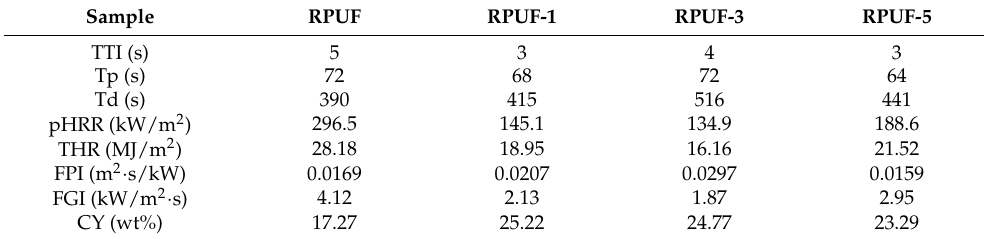
Table 4. Cone calorimetric data of RPUF, RPUF-R composites.